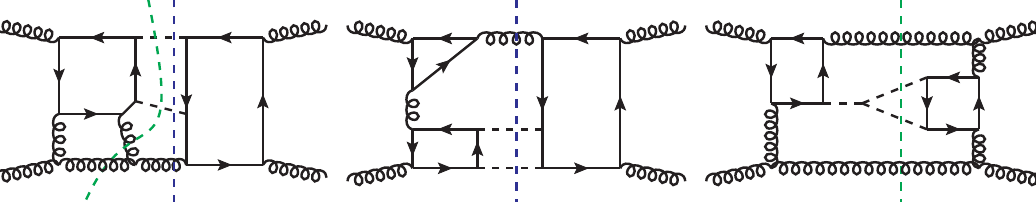
-dependent propagators. To perform the LME, the t limit (denoted by the operator ), leaving t T . t